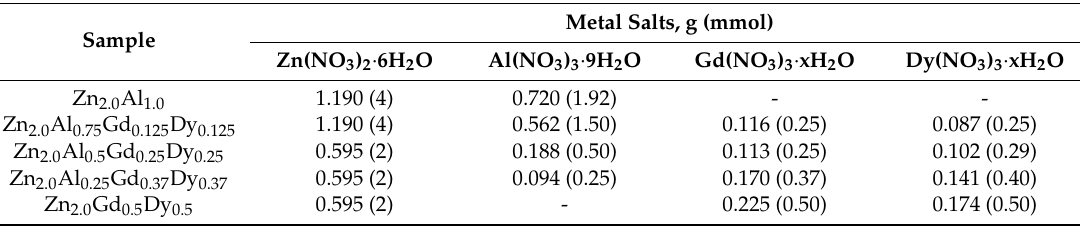
Table 1. Amount of metal salts used in the